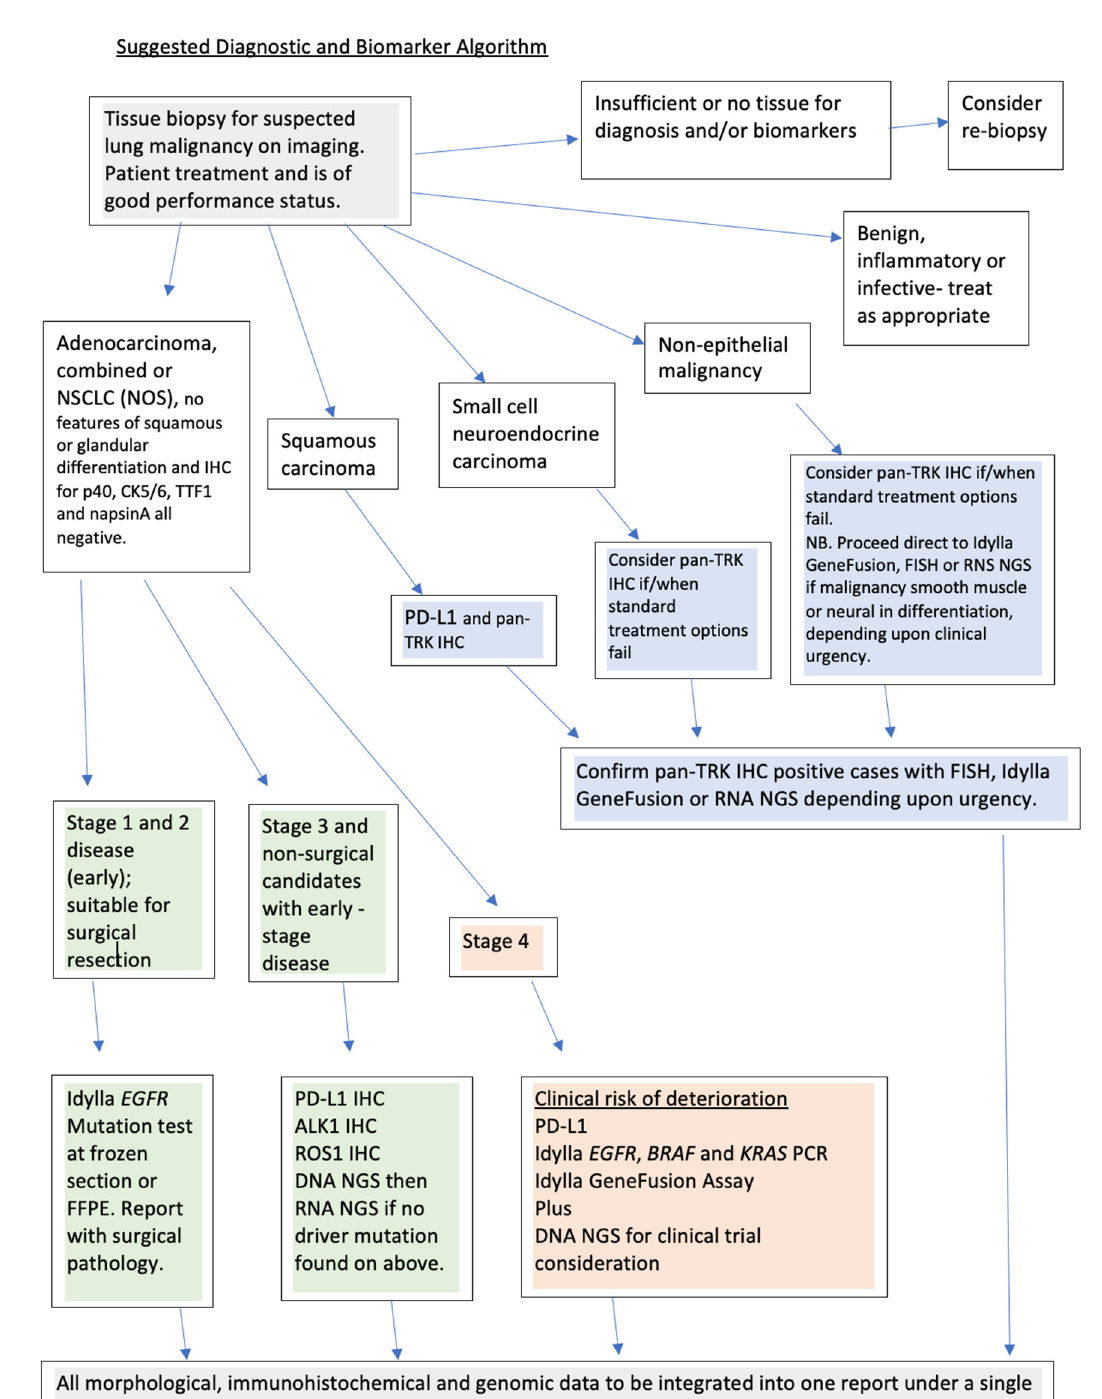
Figure 2. Suggested algorithm for molecular analysis of somatic NSCLC tissue taking into consideration the real-world failure rate of RNA sequencing performed in a centralized service model. NSCLC, non-squamous, non-small-cell lung cancer; PD-L1, programmed death ligand 1; IHC, immunohistochemistry; EGFR, epidermal growth factor; BRAF, B-raf oncogene; KRAS, K-ras oncogene; NOS, not otherwise specified; NTRK, neurotrophin receptor kinase; Trk, tropomyosin receptor kinase (protein); FFPE, formalin-fixed paraffin-embedded tissue.